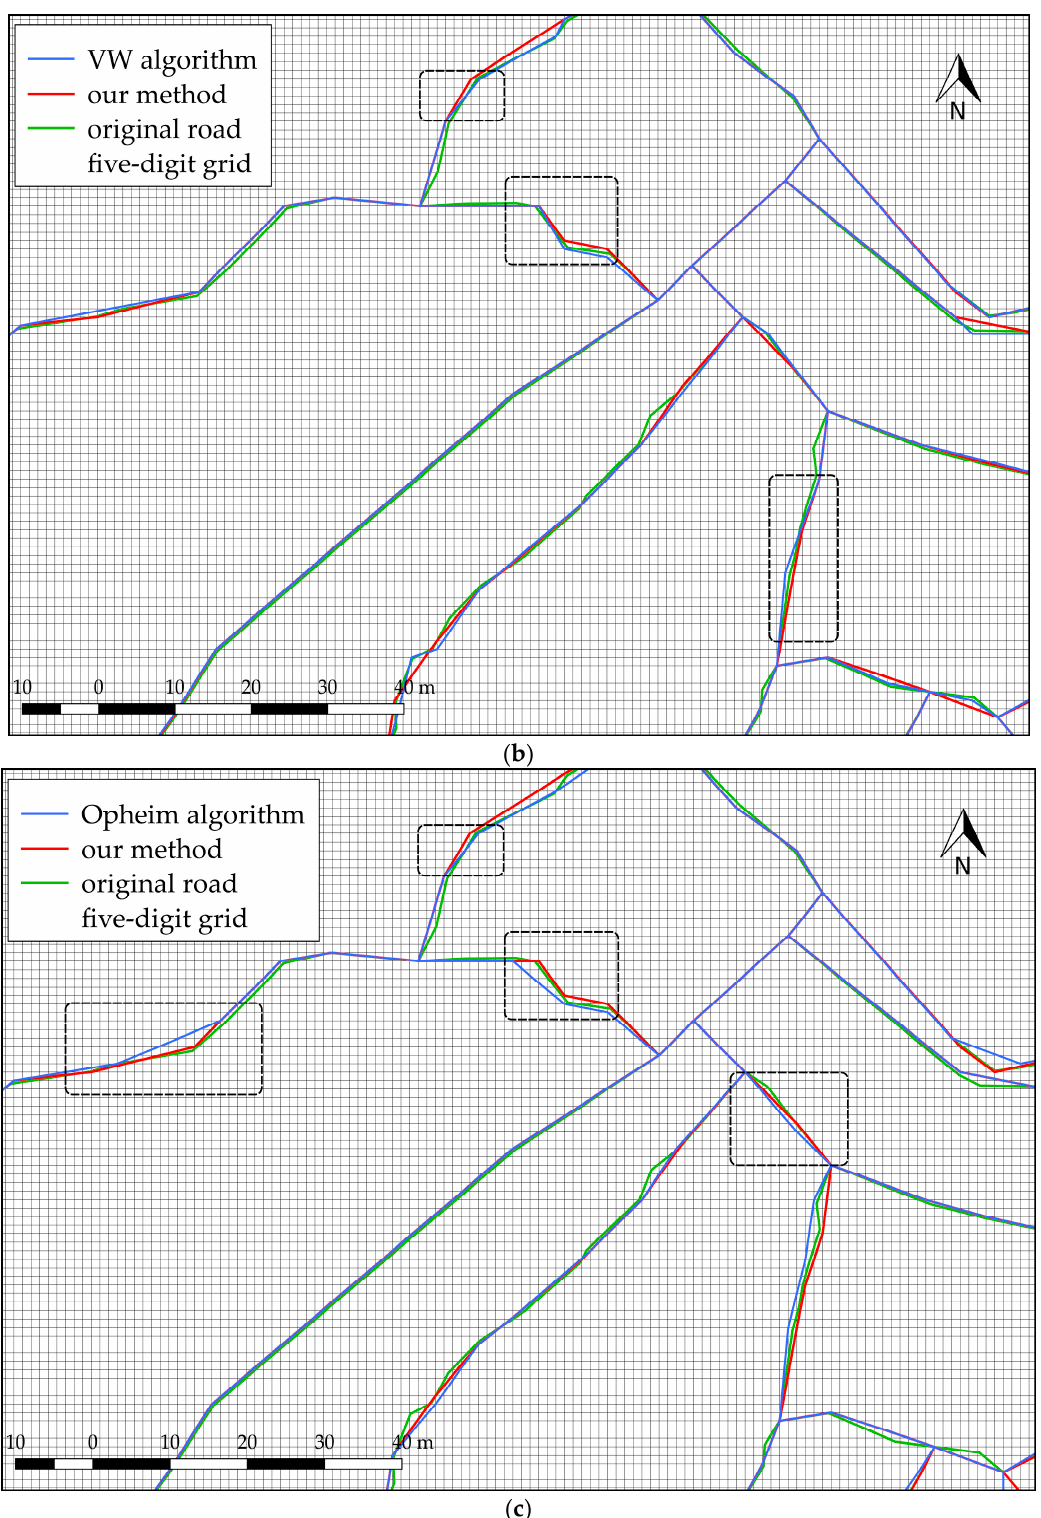
Figure 16. Simplified results of different algorithms. Comparison of ( a ) the DP algorithm and the improved Opheim algorithm; ( b ) the VW algorithm and the improved Opheim algorithm; ( c ) the Opheim algorithm and the improved Opheim algorithm.